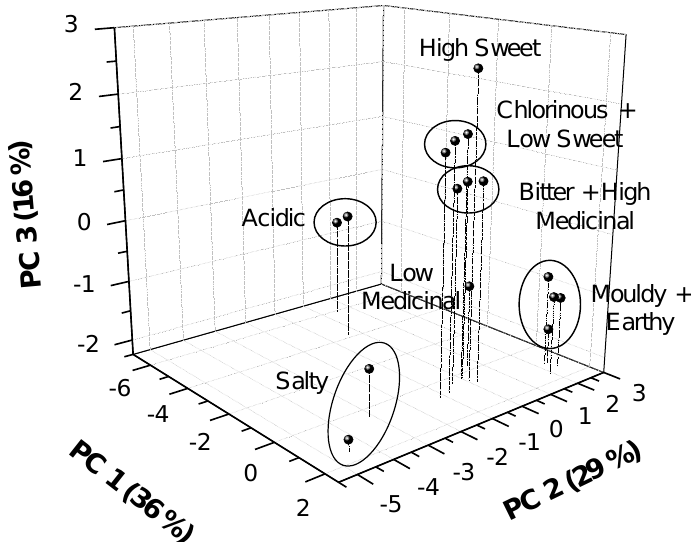
Figure 1. PCA score plot using the three first PC for the 16 synthetic water samples.